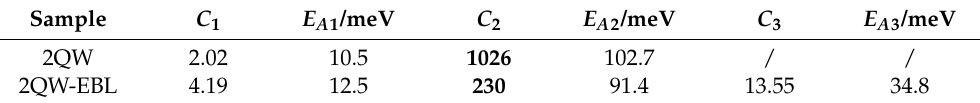
Table 1. The fitting